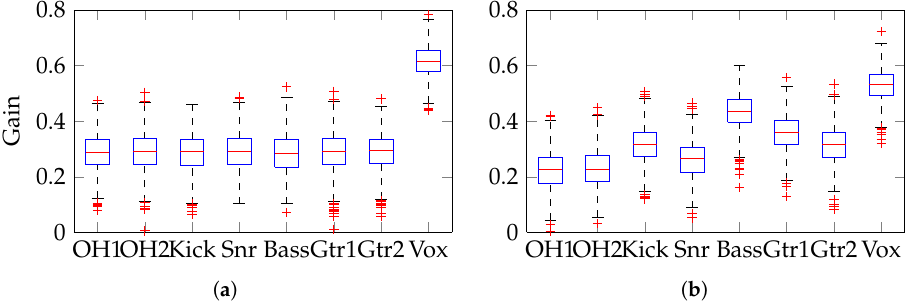
Figure 6. Boxplots of track gains for two generated datasets of mixes, drawn from separate distributions. (a) µ = Equation (7), κ = 200; (b) µ = Equation (8), κ = 200